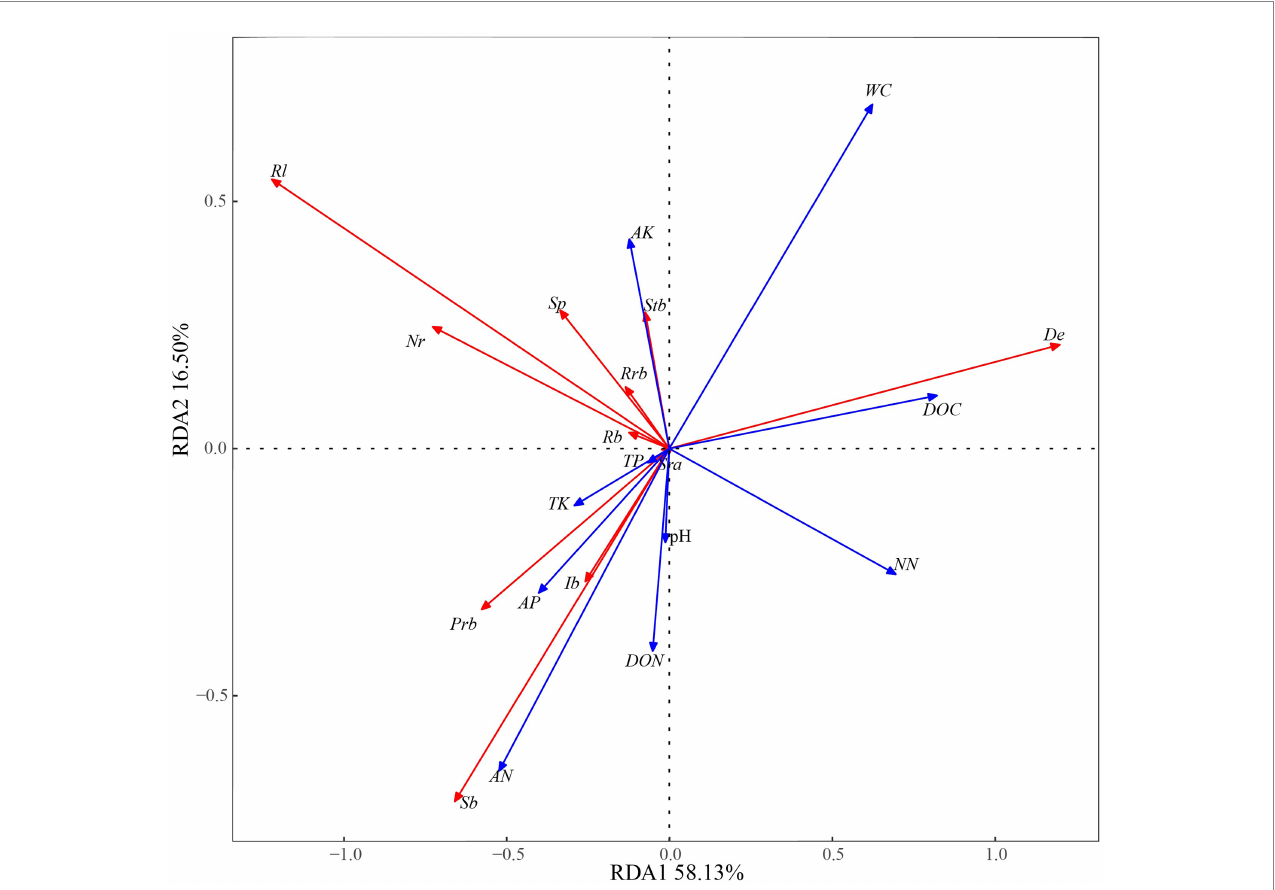
FIGURE 5 Relationship between reproductive characters and soil factors in redundancy analyses. Rl , rhizome length per plant; Nr , number of rhizome buds per plant; Sp , spacer; Rrb , proportion of rhizome bud; Rb , rhizome biomass per plant; Stb , tiller node bud per plant; Sra , sexual reproduction allocation; De , density; Prb , population rhizome biomass; Ib , inflorescence biomass; Sb , sexual plant biomass. pH, Soil pH; AP , Available phosphorus; TP , Total phosphorus; TK , Total kalium; AK , Available kalium; DOC , Dissolved organic carbon; DON , Dissolved organic nitrogen; NN , Nitrate nitrogen; AN , Ammonia nitrogen; WC , Soil water content.